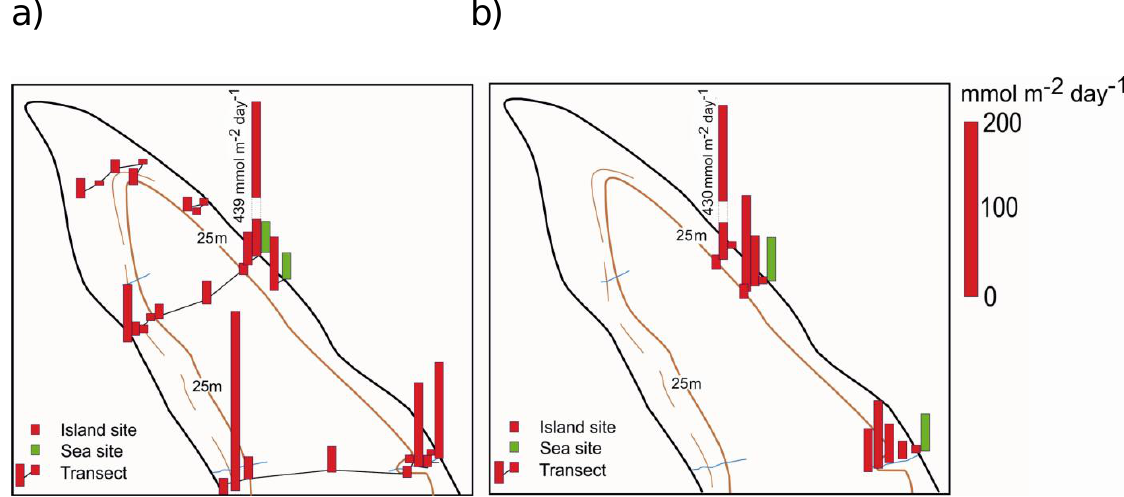
Fig. 17. Distribution of CO 2 out-gassing from Muostakh Island sites (red columns) and from sea sites (green columns) in September 2006 (a) , and in September 2009 (b)